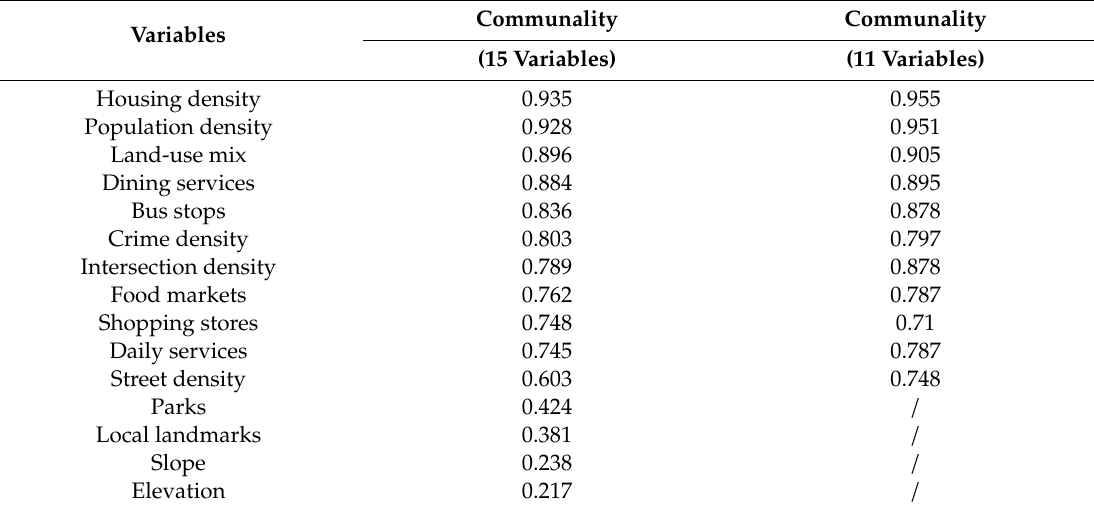
Table 3. Variable selection based on